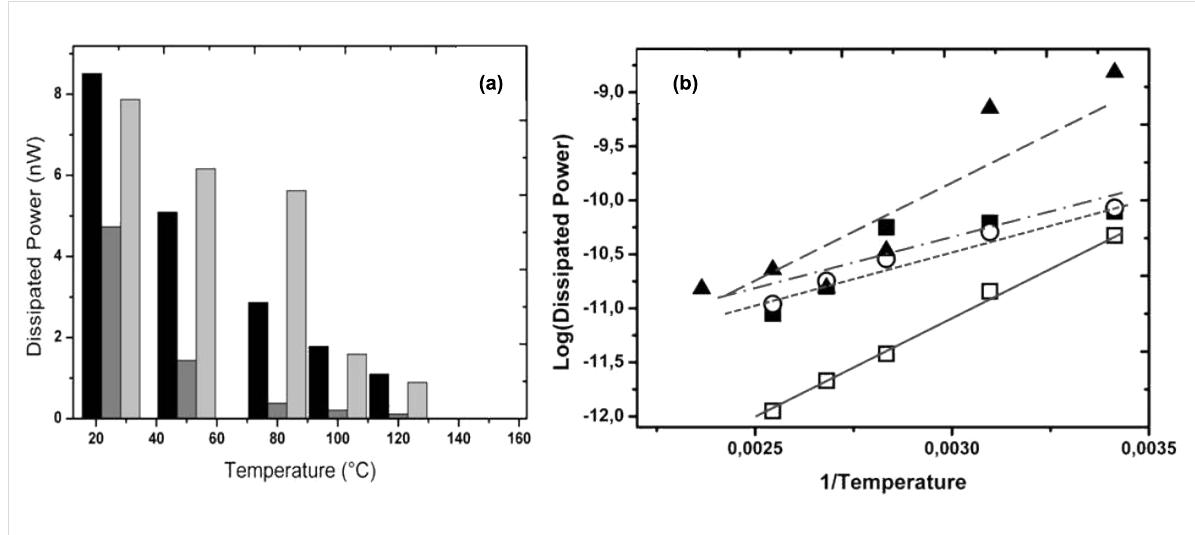
Figure 5: (a) Average power dissipation accompanying the onset of motion of as-synthesized and coated nanoparticles on silicon in air vs tempera- ture. Black columns : as-synthesized NPs that are uniformly distributed on the substrate, dark gray columns : CH 3 -coated NPs, light gray columns : as-synthesized NPs randomly distributed on the substrate. (b) Logarithm of the dissipated power in moving as-synthesized and coated NPs on silicon wafer vs reciprocal temperature. Closed squares : as-synthesized nanoparticules, open circles : as-synthesized nanoparticles ordered organized, open squares : CH 3 -coated nanoaprticles, closed triangles : OH-coated